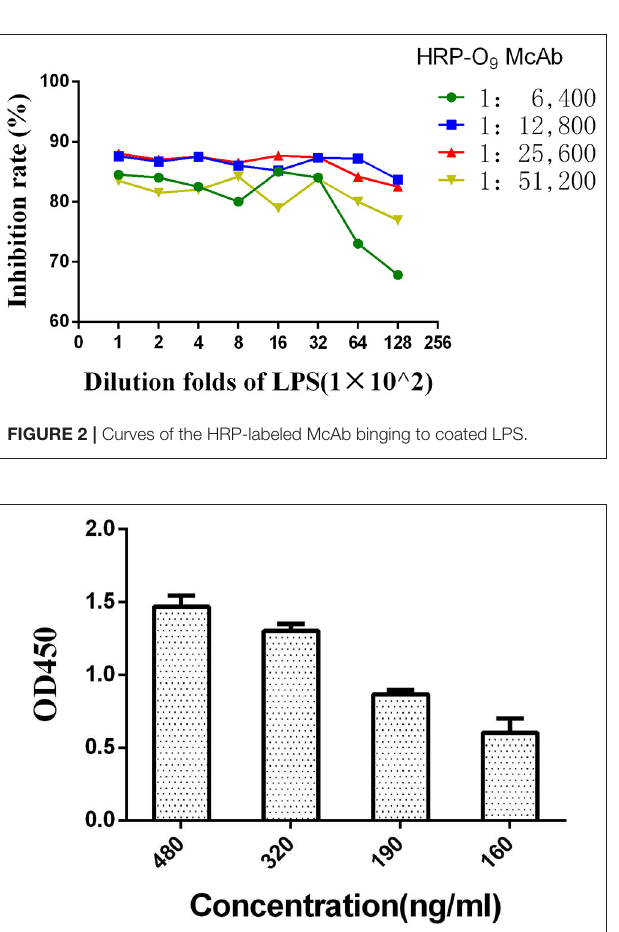
Dc-ELISA could not check out the sera against non- Salmonella and non-O 9 Salmonella . The value of negative sera was more than 1.0 whereas the OD value of positive sera was less than 0.25 as a control ( Figure 9 ) based on P/N ≥